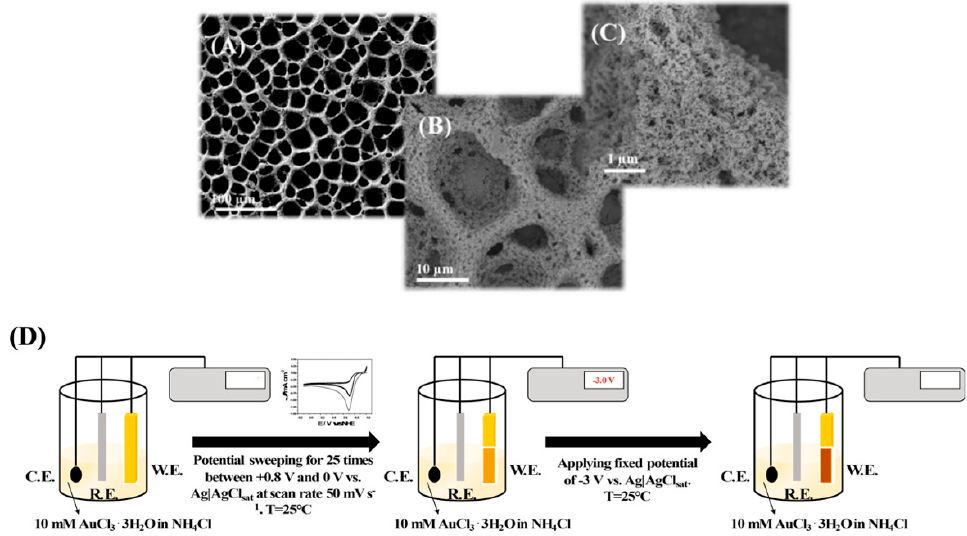
Figure 3. SEM images at di ff erent magnifications ( A ) 100 µ m, ( B ) 10 µ m and ( C ) 1 µ m of the highly PG electrode obtained through a two-step electrodeposition protocol. ( D ) Scheme of the electrodeposition protocol: (i) electrodeposition of additional gold layer by using cyclic voltammetry for 25 cycles between + 0.8 and 0 V vs. SCE; (ii) stepping of − 3 V vs. SCE ensuring an intense hydrogen bubbling. Reproduced with permission from [52]. Copyright American Chemical Society,